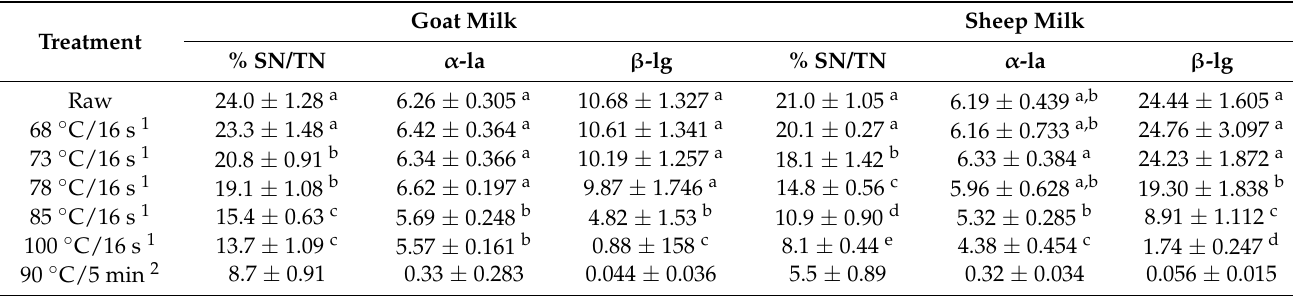
Table 2. Soluble nitrogen and residual native whey proteins (expressed as peak areas of the RP-HPLC profiles) of heat- treated goat and sheep milk as compared to the respective raw milk; means ± standard deviation. SN/TN, pH 4.6 soluble N/total N by means of the Kjeldahl method; α -la, α -lactalbumin and β -lg, β -lactoglobulin. Different letters indicate significant differences (LSD, p < 0.05) between the means of different heat treatments. Goat Milk Sheep Treatment